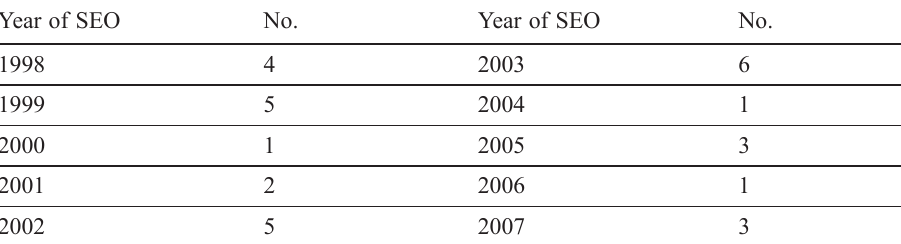
Table 3. Yearly distributions of international equity issues